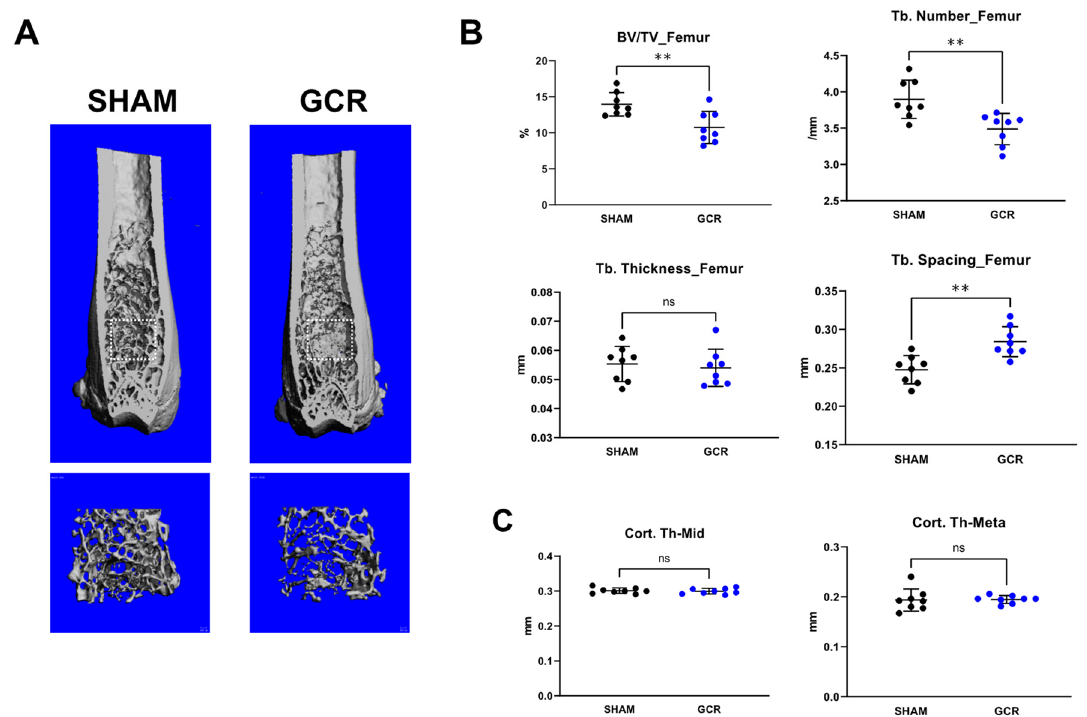
Figure 1. GCR induced trabecular bone loss in adult male mice 3 months after exposure. ( A – C ) Imaging and quantification of femoral bones from sham and GCR exposed male mice by micro-CT after sacrifice (n = eight animals/group). ( A ) Representative images of the femoral bone. ( B ) Trabecular bone measurements of the distal femur were made on 151 transverse slices that were taken from the epicondyles, extending toward the proximal end of the femur; cortical bone and primary spongiosa were manually excluded from the analysis. Trabecular bone parameters demonstrated significant decreases in the percentage of trabecular bone volume to tissue volume (BV/TV) and trabecular number (Tb. Number) and a significant increase in trabecular spacing (Tb. Spacing). ( C ) No significant changes were observed in cortical thickness in midshaft (Cort. Th-Mid) or metaphysis (Cort. Th-Meta). Data are presented as mean ± SD. p values were determined using Student’s t -test. (n = 8, ** p < 0.01., n.s.: not significant).